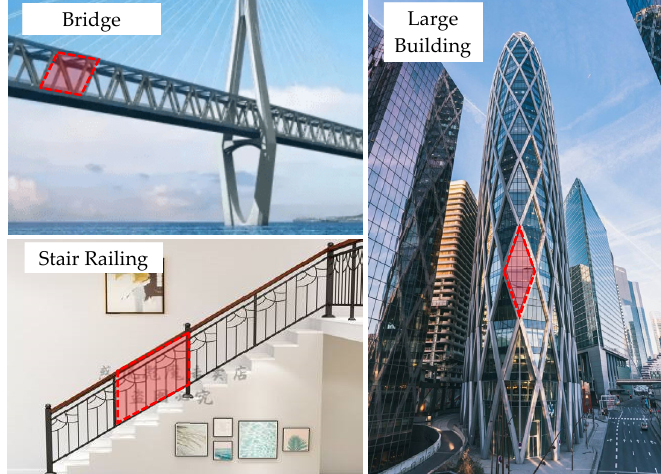
Figure 1. Examples of parallelogram structures on buildings.